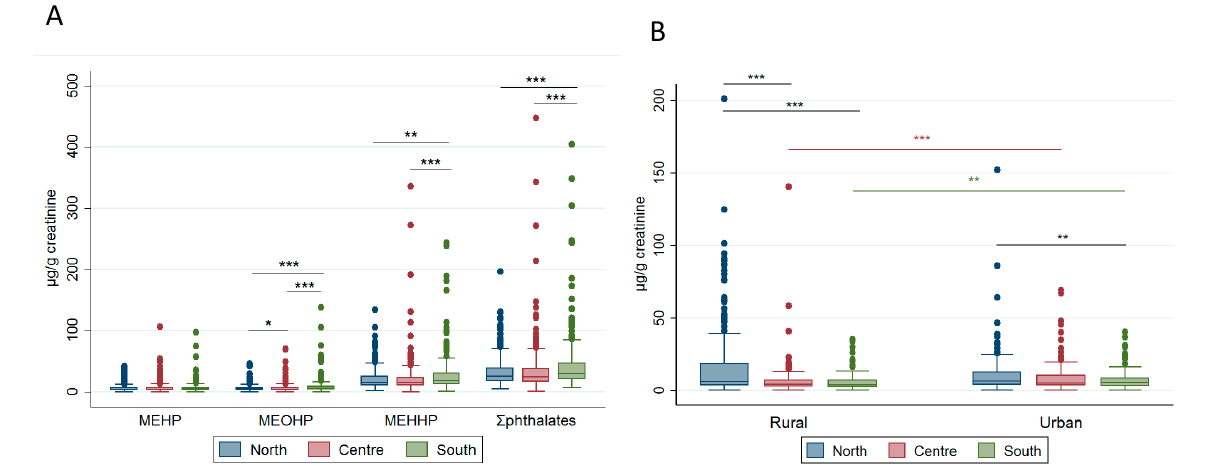
Figure 1. Box plots for DEHP metabolites (panel ( A )) and BPA levels (panel ( B )) in urine samples of Italian women residing in the north, centre, and south of Italy. For BPA data, rural and urban areas are also considered. Data were normalized to urine creatinine concentration ( µ g/g). Two outlier values were excluded from the graph for a better visualization. Black lines and asterisks indicate statistical differences among macro-areas; red and green bars/asterisks indicate statistical differences between rural and urban areas in the centre and south of Italy, respectively. Asterisks indicate the level of significance: * p < 0.05, ** p < 0.01, and *** p < 0.001.